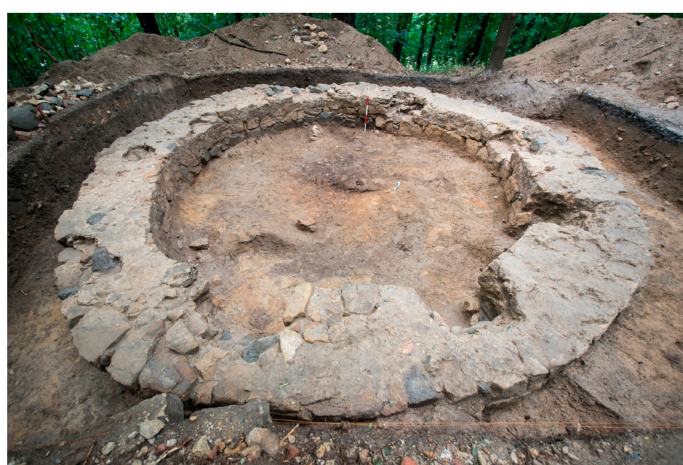
Figure 6. Unearthed gallows buttress at Złotoryja site. Photo by M.